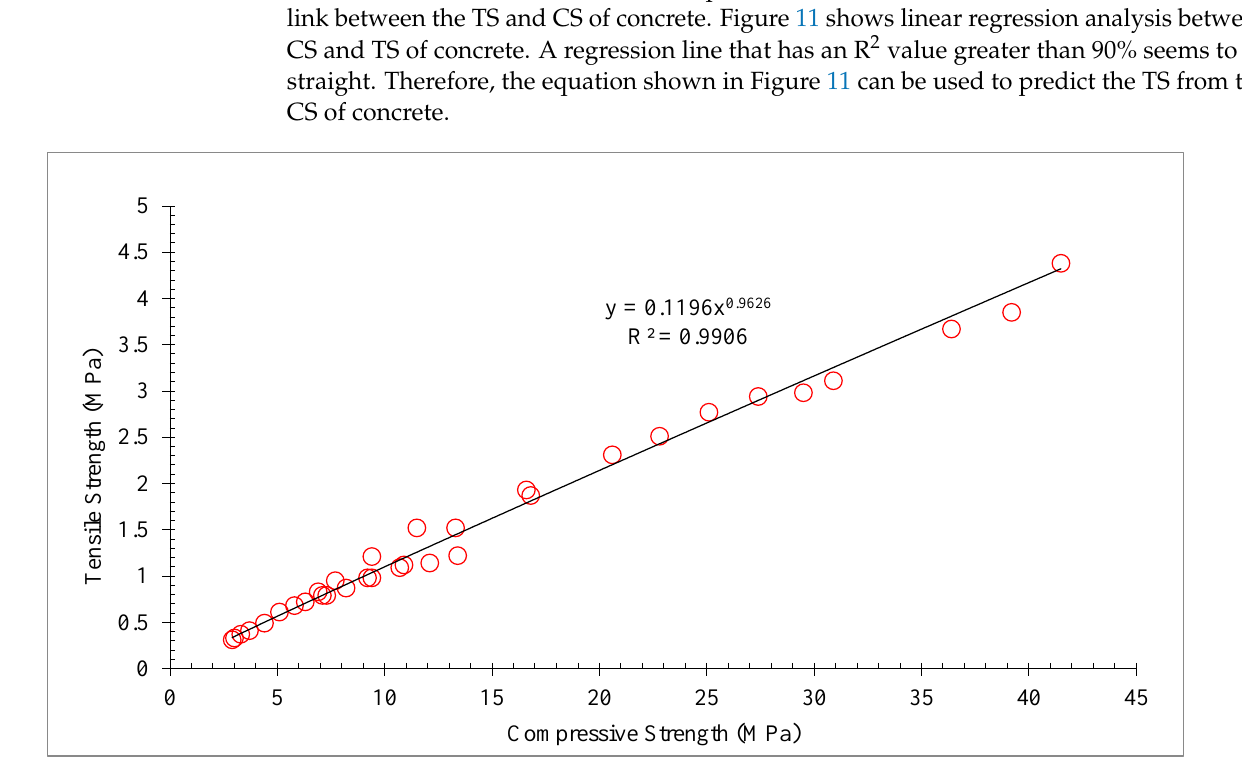
Figure 12. Flexural strength: data source [30].